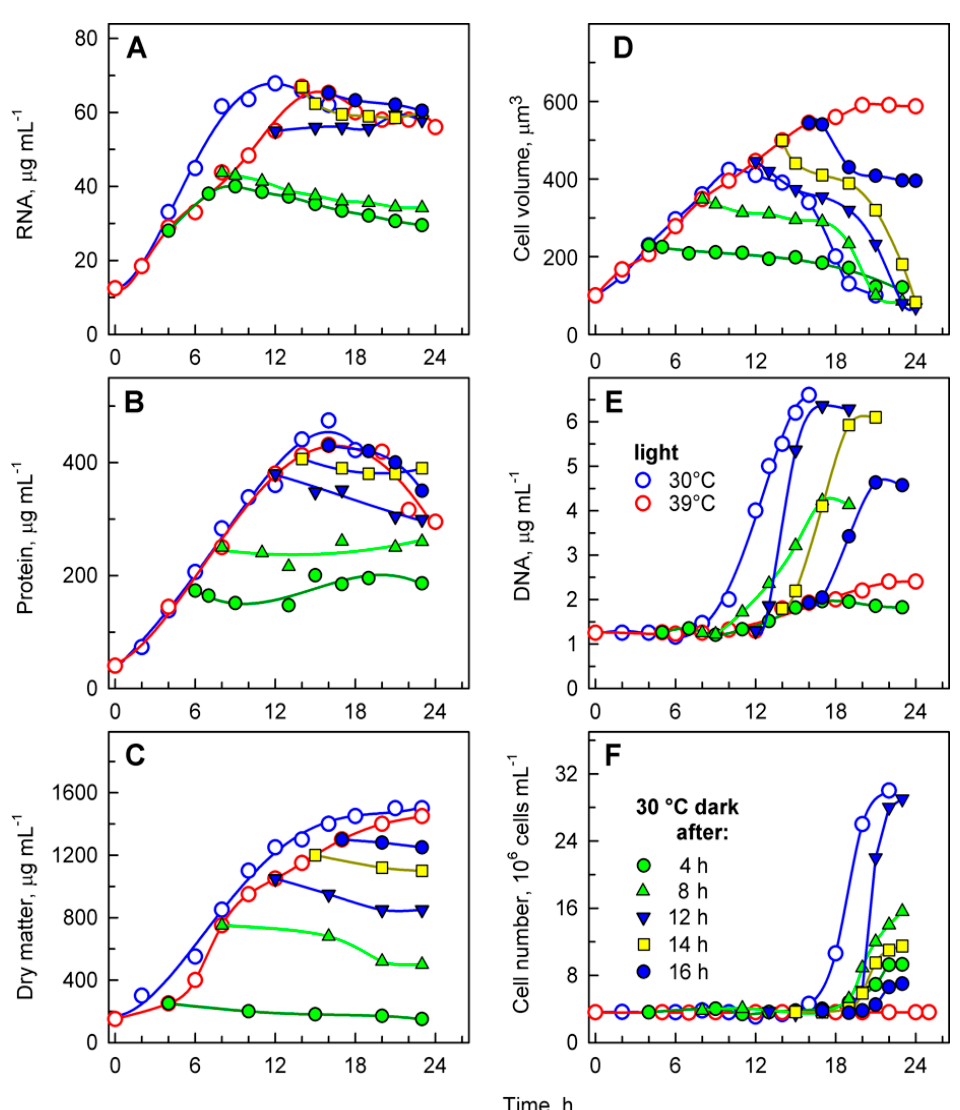
Figure 6. Changes in total RNA ( A ), total protein ( B ), dry matter ( C ), mean cell volume ( D ), DNA ( E ), and number of cells ( F ) in synchronized populations of Chlamydomonas reinhardtii grown at 30 °C (blue open circles), 39 °C (red open circles), and transferred from 39 °C into the dark at 30 °C at the 4th hour (green solid circles), 8th hour (green solid triangles), 12th hour (blue solid converted triangles), 14th hour (yellow solid squares), and 16th hour (blue solid circles), respectively .